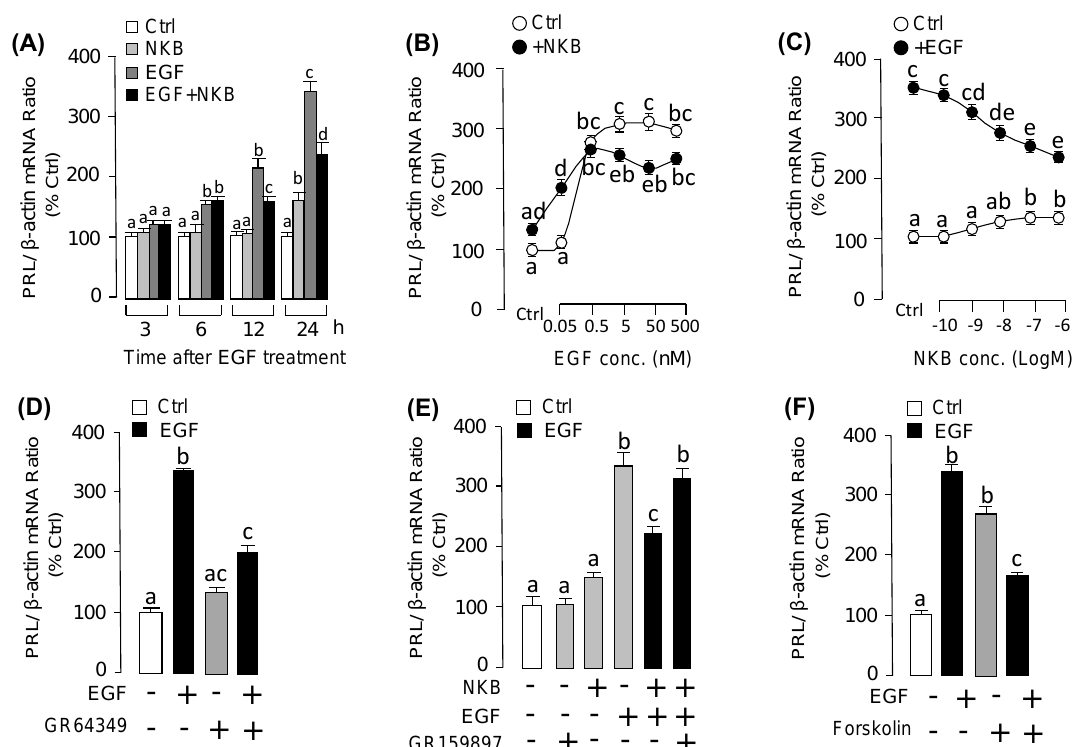
Figure 7. The effect of EGF and NKB on PRL mRNA expression in grass carp pituitary cells. ( A ) Time course of EGF (50 nM), NKB (1 µM), EGF (50 nM) + NKB (1 µM) on PRL mRNA expression. ( B ) Dose experiment of 24-h incubation with increasing dose of EGF (0.05–500 nM) on basal